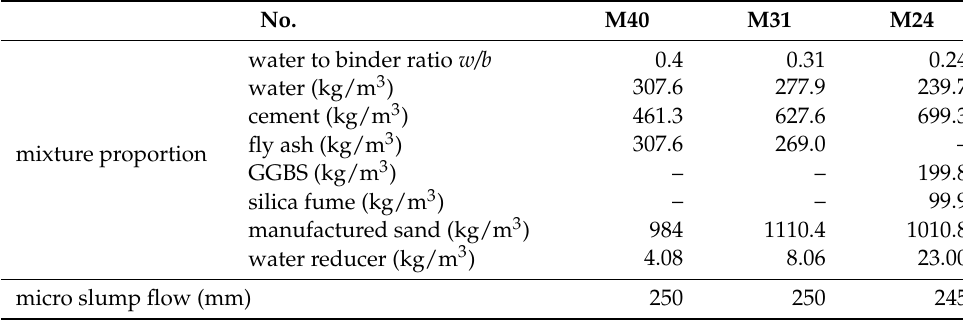
Table 1. Mixture proportion and workability of